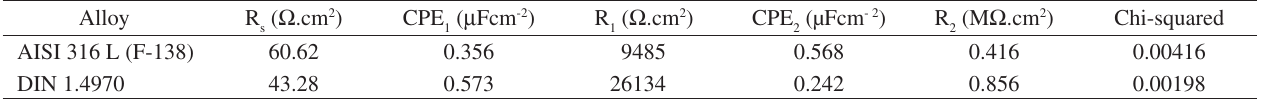
Table 4. Results of the parameters obtained from the fitting of the equivalent circuit for the experimental data obtained for AISI 316L (ASTM F-138) and DIN W. Nr. 1.4970 SS in PBS solution at room temperature. Alloy AISI 316 L (F-138)